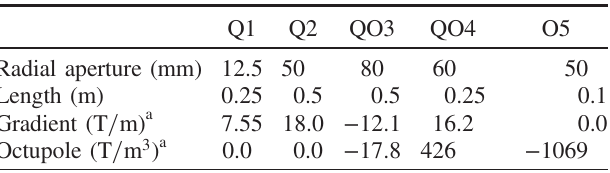
TABLE III. Properties of the normal conducting resistive magnets. Q1 Q2 QO3 QO4 O5 Radial aperture (mm) 12.5 50